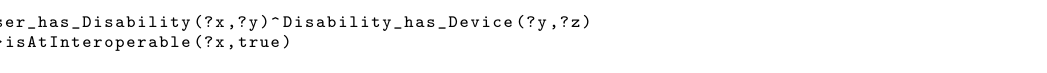
Listing 1. SWRL rule for inferring the property of assistive technology